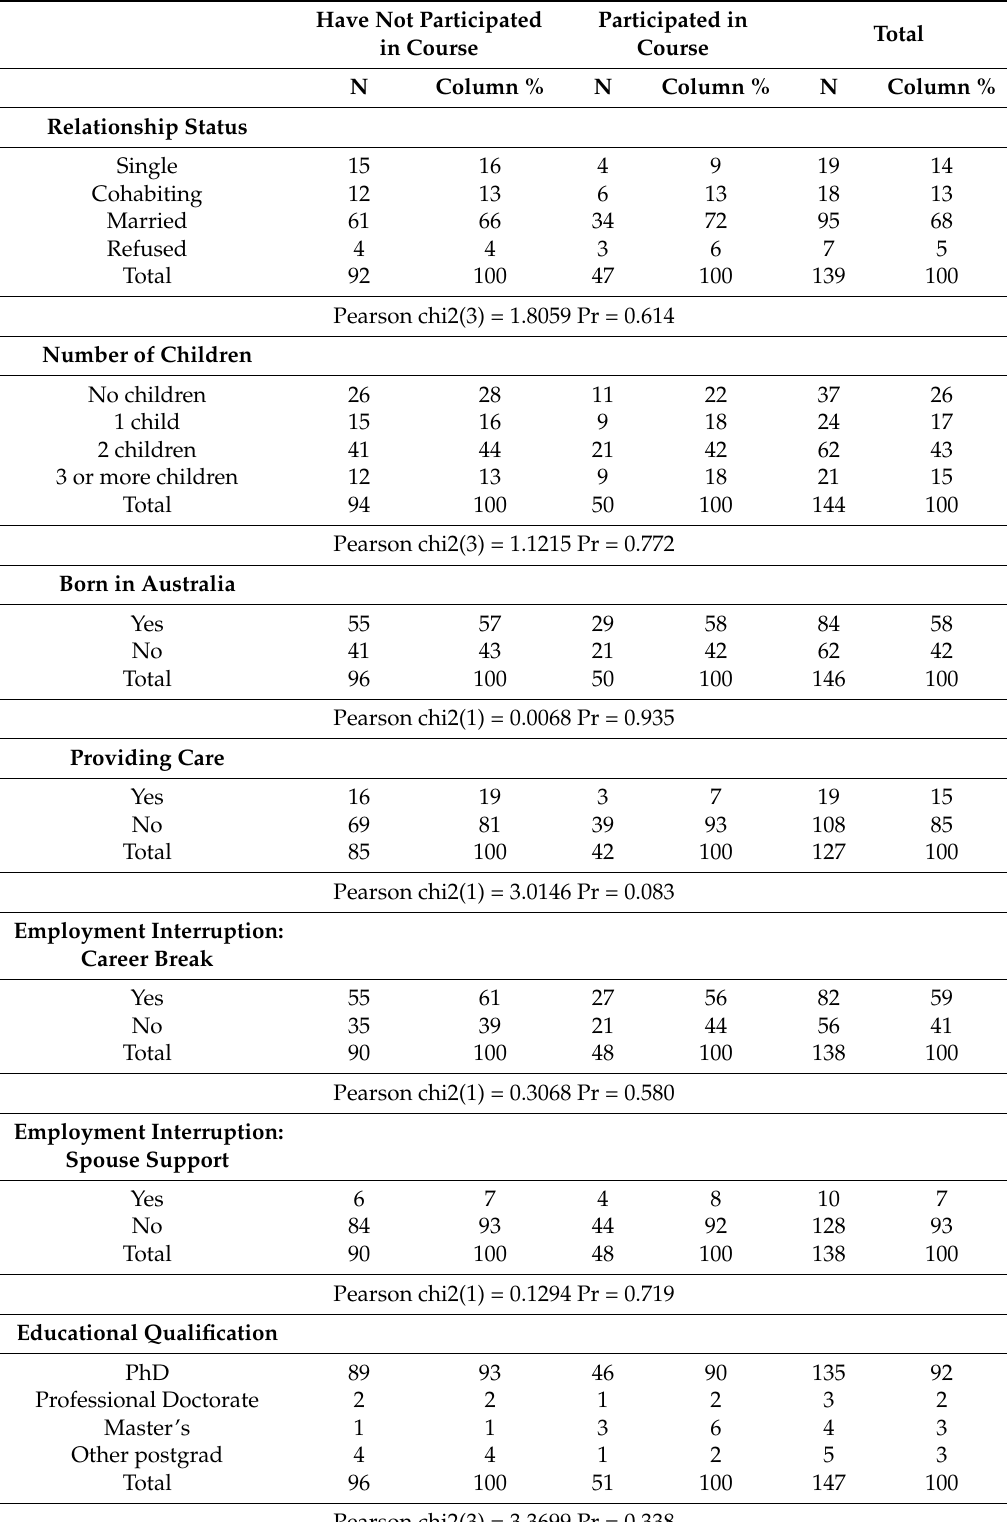
Table 1. Women at Level C between 2010 and 2015: social and demographic characteristics of women who have not attended the career progression course and women who have attended the